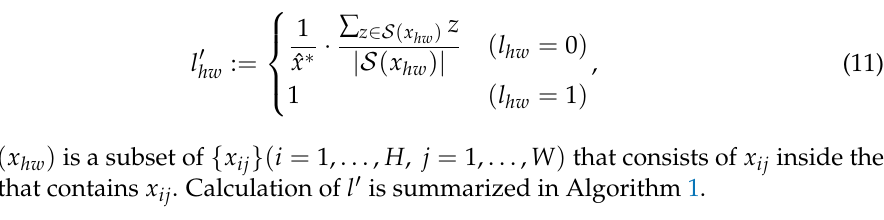
Algorithm 1 Estimation of shadow intensities using a pixel-level binary